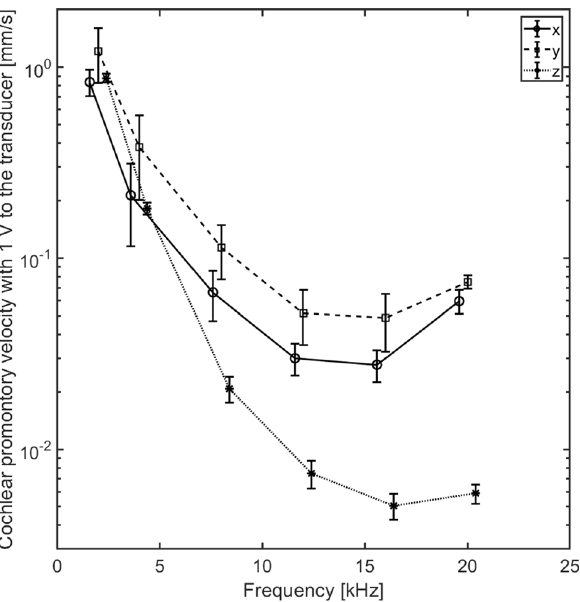
Figure 8. The average cochlear promontory velocity in three orthogonal directions when the stimulation is at the top of the guinea pig vertex. The stimulation is 1 V to the BC transducer. The error bars indicates the standard error of the